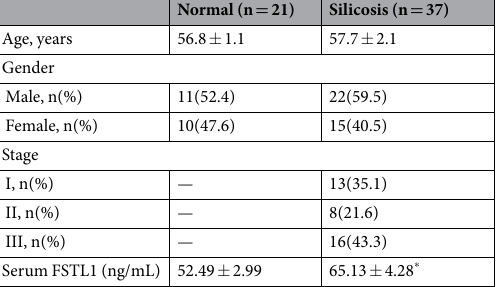
Table 1. Clinical characteristics of the study groups. Values are mean ± SEM. * P < 0.05, significant difference compared with